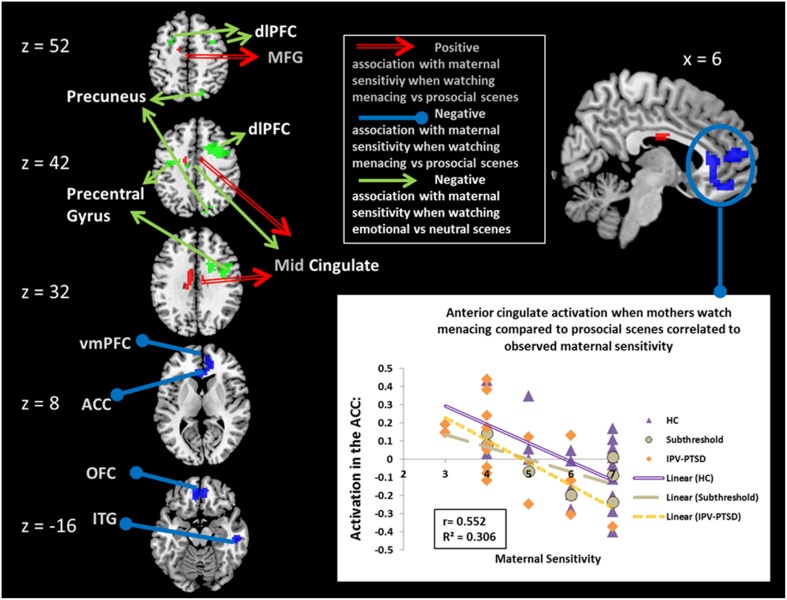
Partial correlations of maternal sensitivity with BOLD effects corrected for IPV-PTSD symptom severity. Red, positive association when mothers watch scenes of menacing vs. prosocial male–female interactions; blue, negative association when mothers watch scenes of menacing vs. prosocial male–female interaction; green, negative association when mothers watch scenes of emotional (menacing and prosocial scenes combined) vs. neutral male–female interaction. dlPFC, dorsolateral Prefrontal Cortex; MFG, Medial Frontal Gyrus; vmPFC, ventromedial Prefrontal Cortex; ACC, Anterior Cingulate Cortex; OFC, Orbitofrontal Cortex; ITG, Inferior Temporal Gyrus.